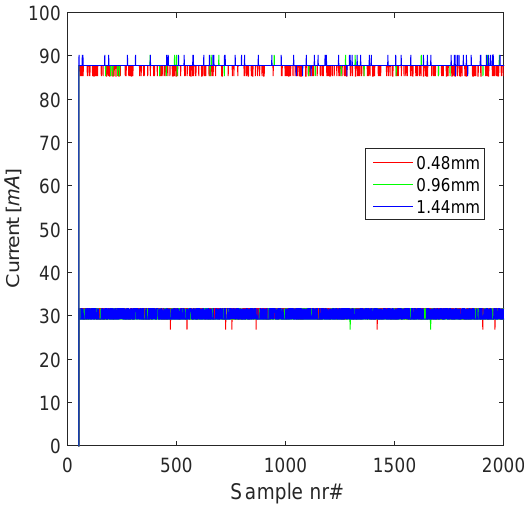
Figure 10. Typical raw ADC values for three different air-gaps (0.48mm, 0.96mm and 1.44mm) showing the initial ( upper line) and final ( lower line) current for each measurement. The noise corresponds to a one LSB (Least Significant Byte) noise in the ADC